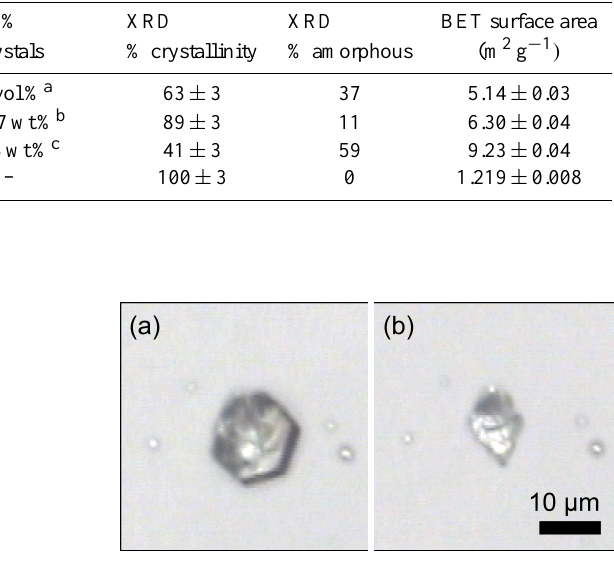
Figure 2. 50x optical image of an ice particle at 225K (a) and its Fuego ash nucleus (b)